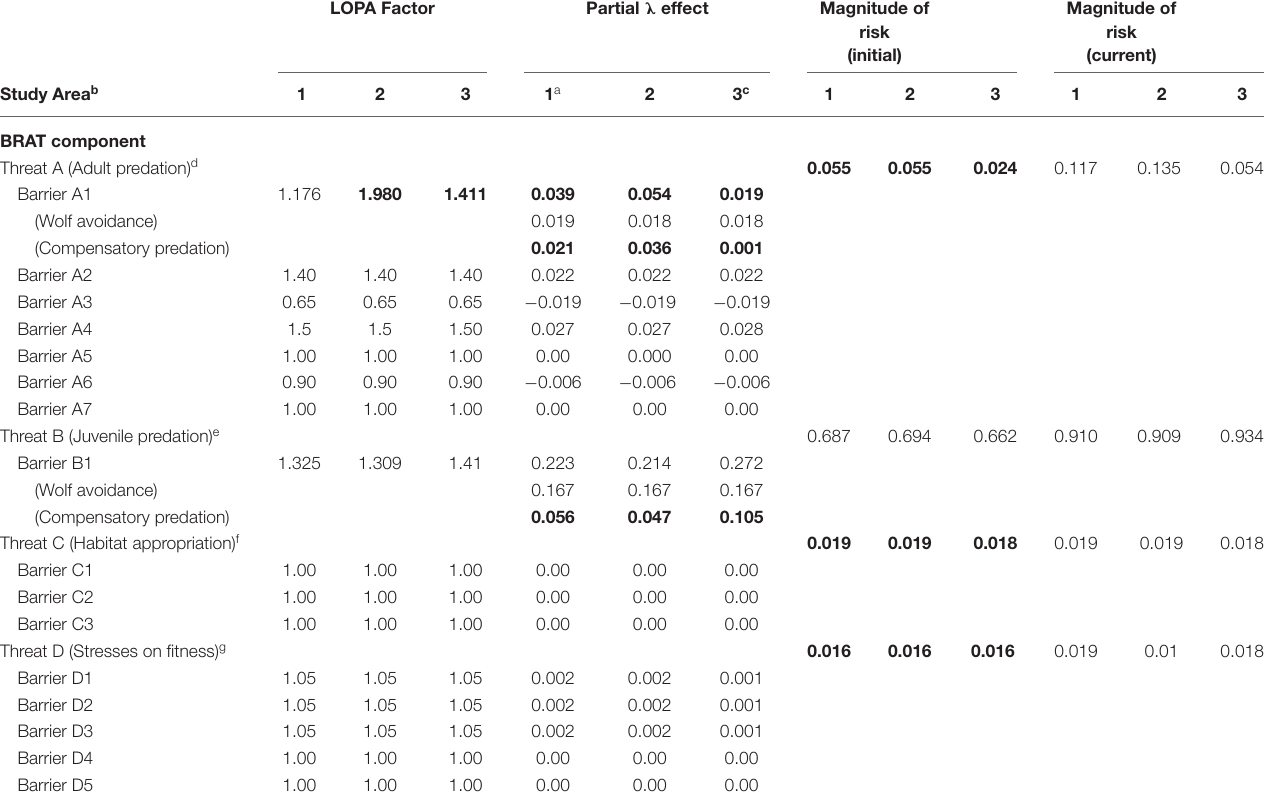
TABLE 3 | Input values for two study areas (Study Areas 1 and 3) having Woodland boreal caribou in Northeastern British Columbia, Canada, under the presented BRAT framework. Bolded values are calculated using the BRAT framework. LOPA Factor Partial λ